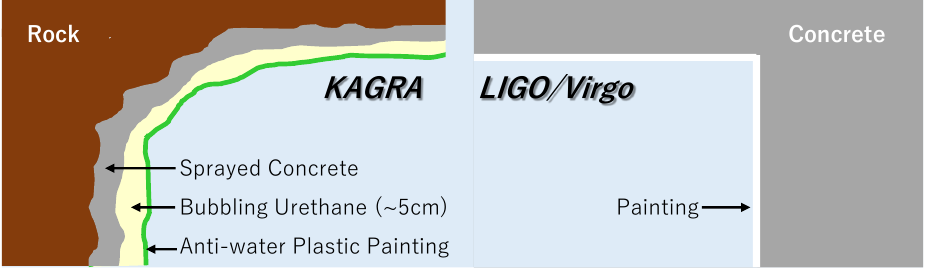
Figure 14. Schematic view of the walls in the experimental sites of KAGRA and